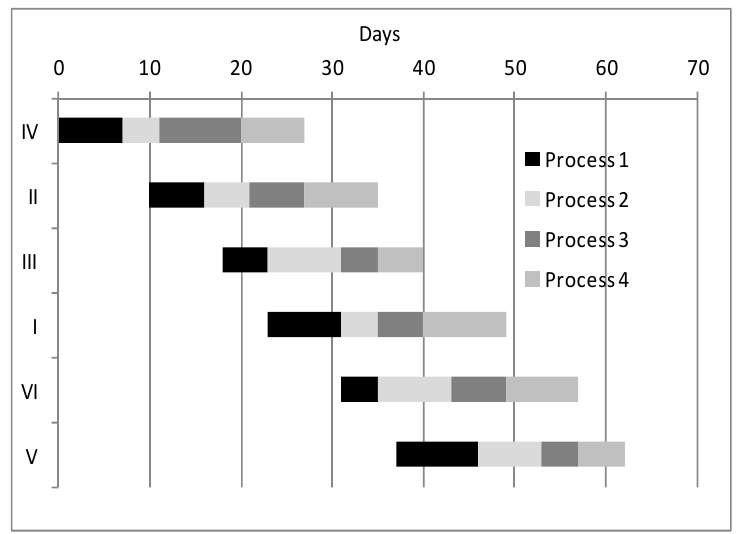
Figure 3. Example: optimal schedule with the constraint that the project must start in zone IV.